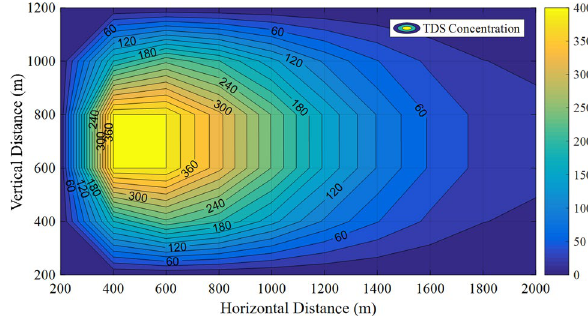
Fig. 8 TDS concentration distribution after 5 years Table 2 Contaminant concentration values in monitoring nodes